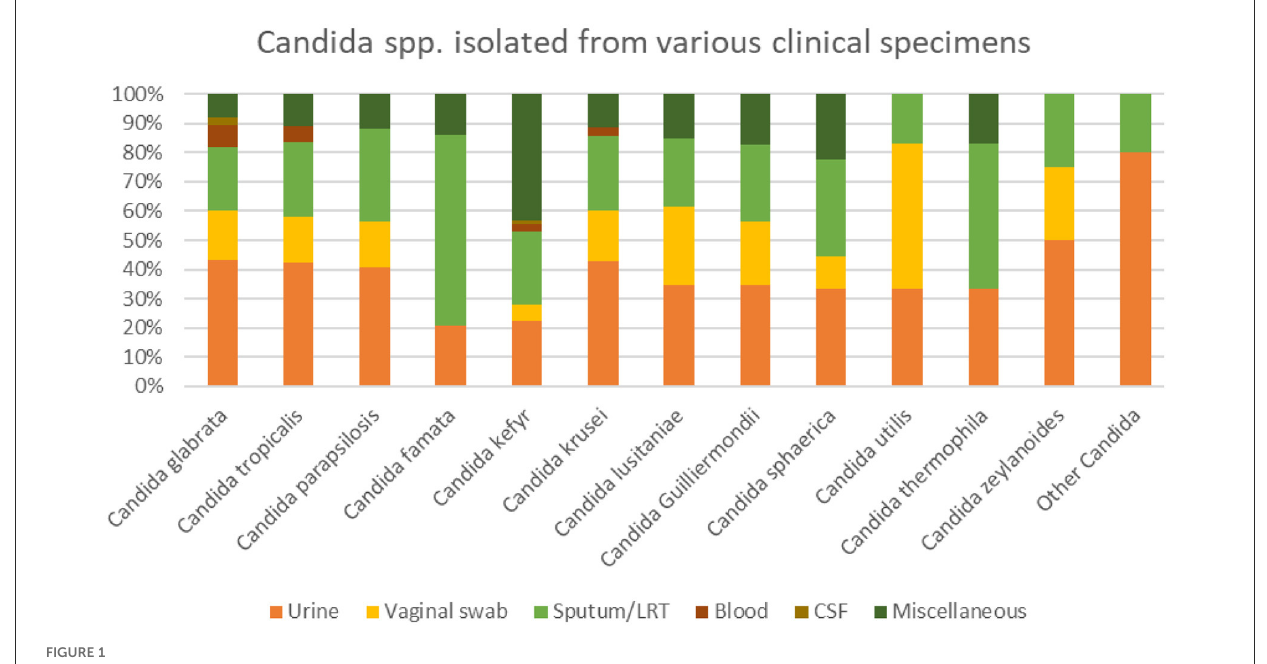
FIGURE1 Candida spp. isolated from various clinical specimens.